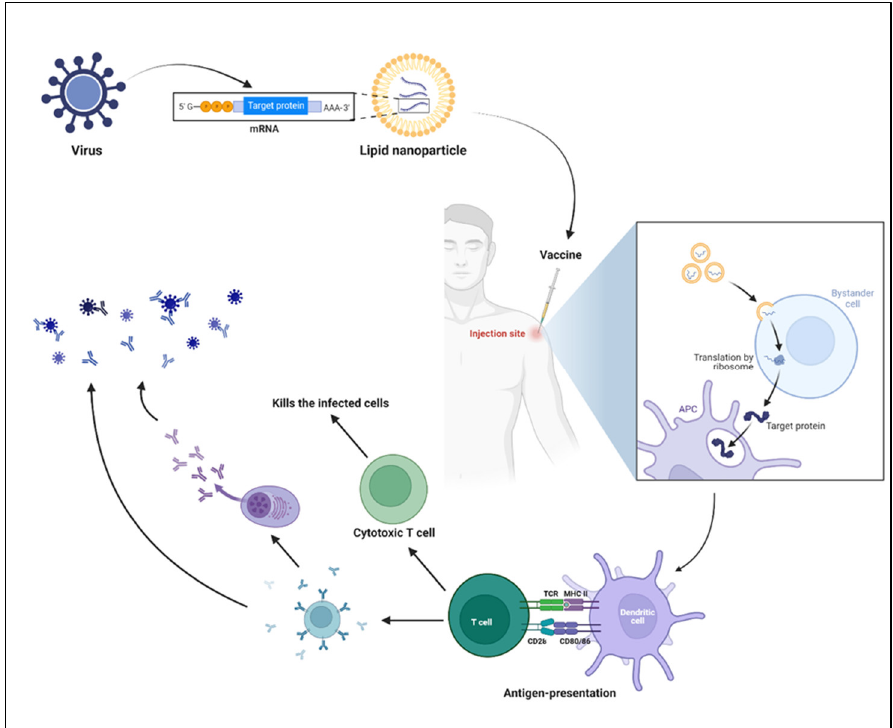
Figure 5. Immune response by mRNA vaccines. LNPs are prepared by encapsulating mRNA, which encodes the viral protein of interest. Upon injection of vaccines, muscular cells take up the LNPs following the release of mRNA into the cytosol and translation of target protein with the help of host machinery. In parallel, the danger associated signals produced by the LNPs recruit the innate immune cells, including neutrophils, monocytes, macrophages, dendritic cells, and others. The antigen-presenting cells (APC) process and present the antigen to the T cells, which further polarizes into effector T cells and helps in B cell-mediated responses. The cytotoxic T cells produced upon activation kill the infected cells, and antibodies (produced by B cells or plasma cells) neutralize the virus.